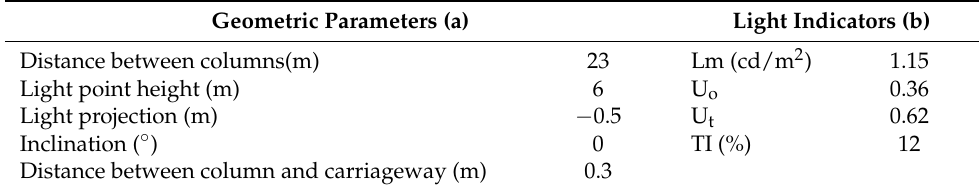
Table 2. Lighting simulation results.